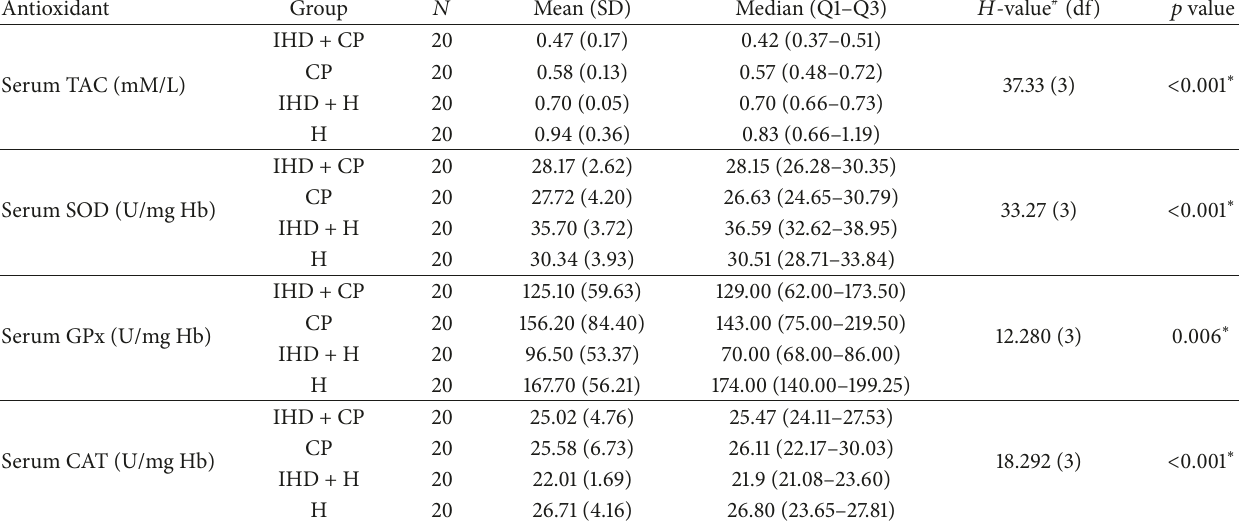
Table 1: Comparison of serum levels.